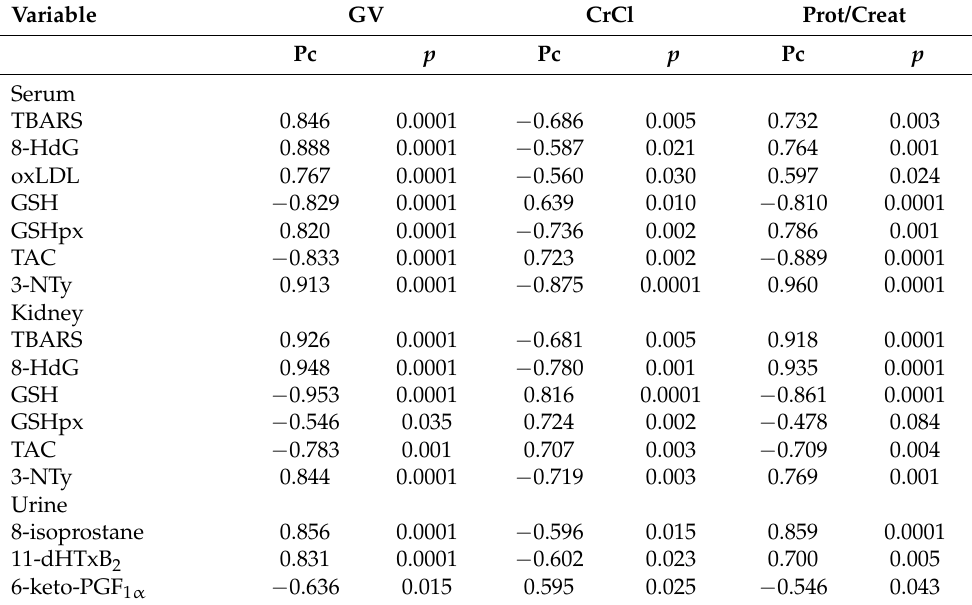
Table 3. Pearson correlations between glomerular volume (GV), creatinine clearance (CrCl), and the proteinuria/urine creatinine ratio (Prot/Create) and biochemical variables in serum, kidney, and